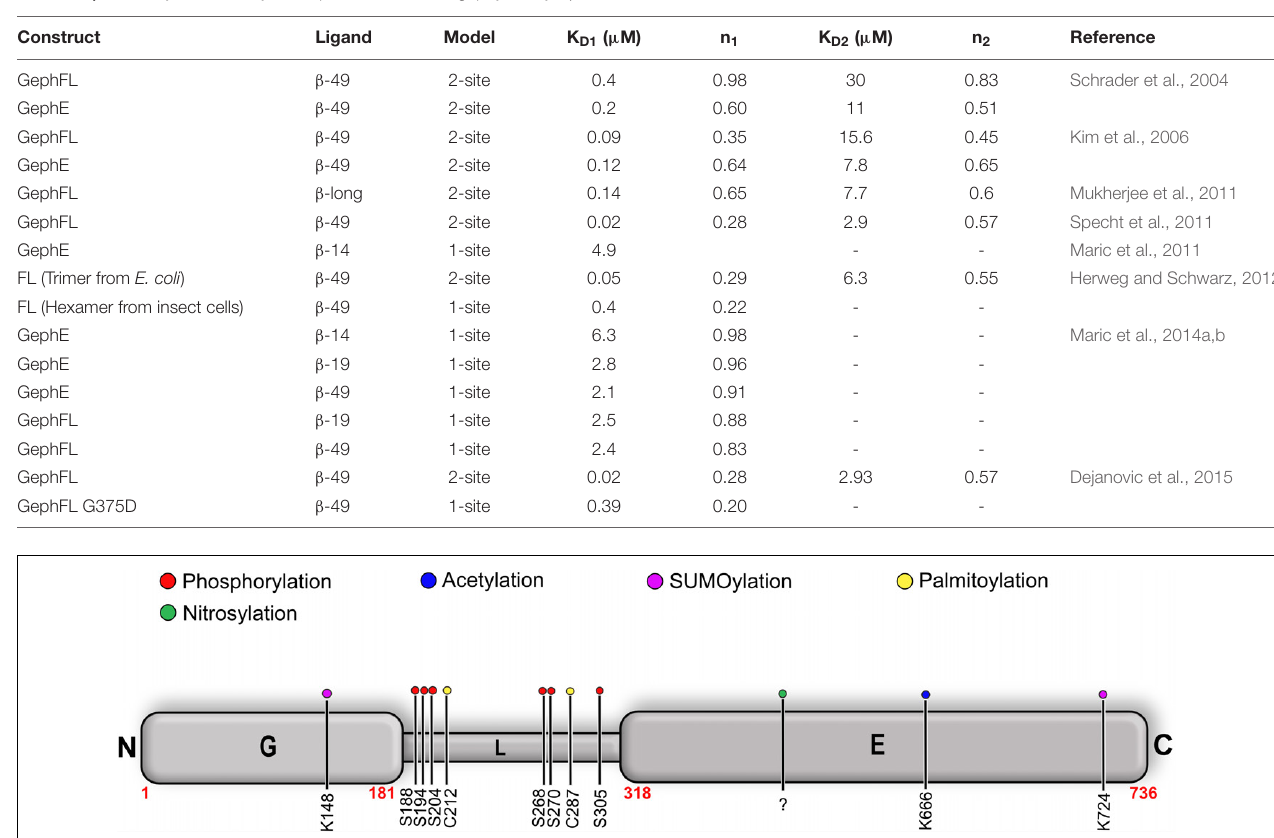
FIGURE 9 | Post-translational modifications (PTMs) of gephyrin. Schematic representation of well-characterized PTMs of gephyrin where the different PTMs are colored according to the accompanying scheme. Location of the PTM as indicated by corresponding residue number and type.